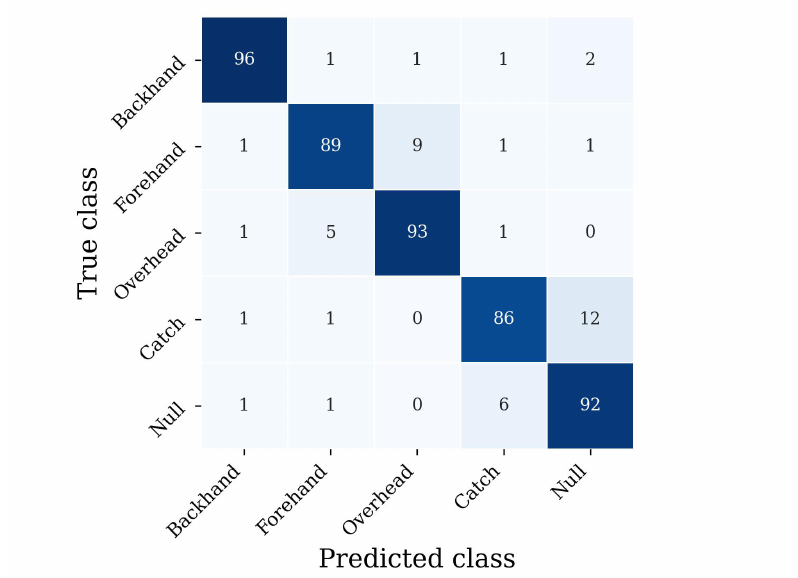
Figure 6. Confusion matrix for the aggregated class problem (no distinction between flat, outside- in and inside-out throws). Each entry is normalized according to the true class and denoted in percentage. Thus, the highest possible value is 100, and the smallest possible value is